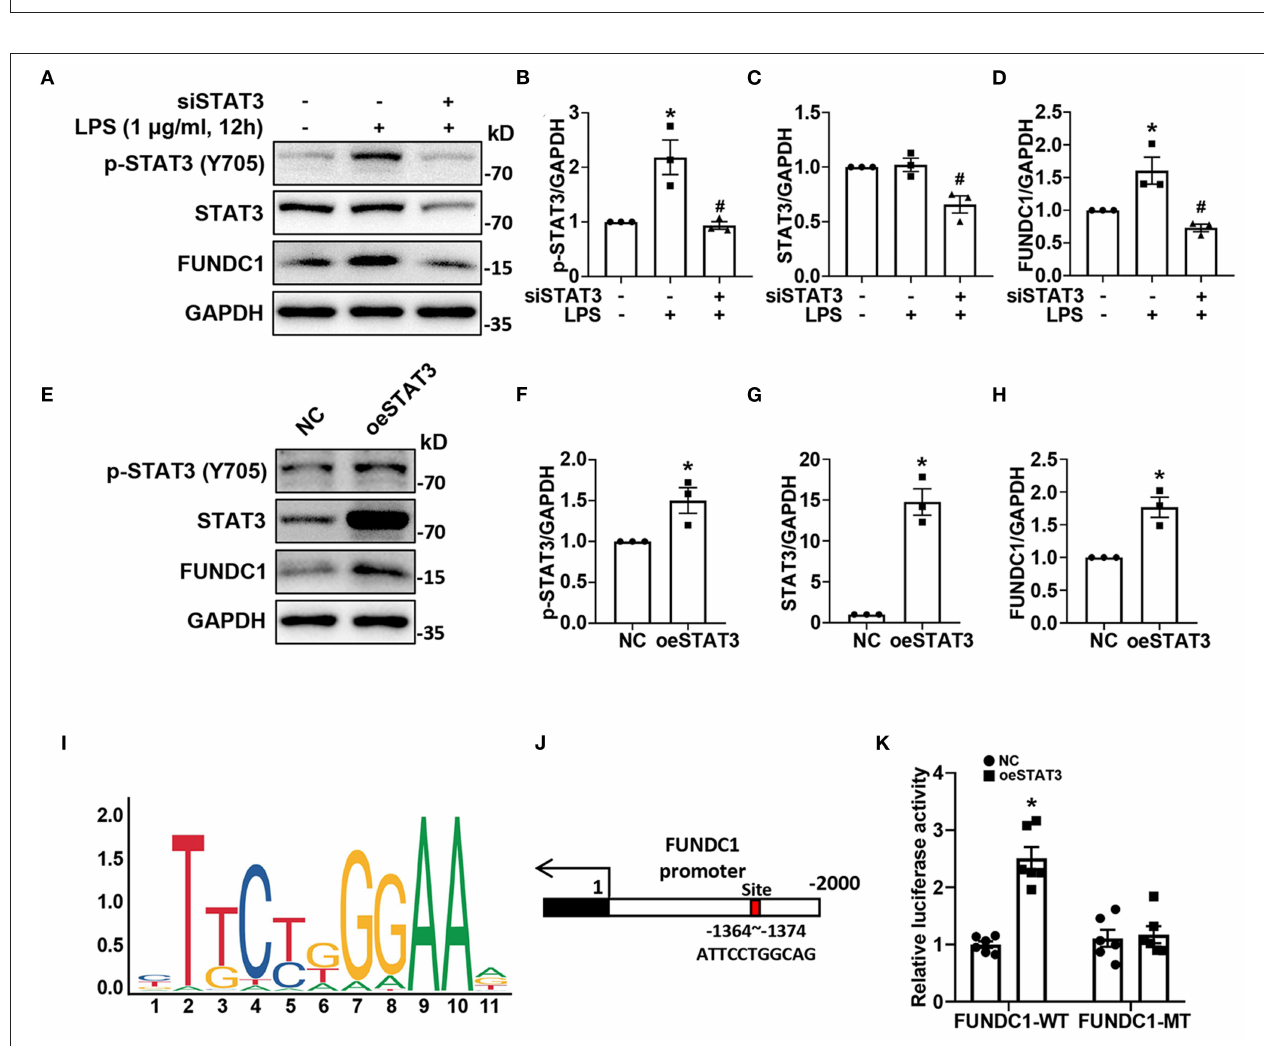
FIGURE 3 | H9c2 cells were pretreated with 5 µ M Bazedoxifene for 1h and then stimulated by LPS (1 µ g/ml) for another 12h. Western blot was used to determine the levels of p-STAT3 and STAT3. (G,H) Representative immunofluorescence images and quantification for p-STAT3. Scale bar: 100 µ m. (I) Quantification of IL-6 mRNA level. (J,K) The impact of various concentrations of sIL-6R on the activation of STAT3 induced by LPS. H9c2 cells were co-treated with LPS and sIL-6R (0, 2.5, 5, 10, 20ng/ml) for 12h. Representative western blot images and quantification of p-STAT3 and STAT3 were as indicated in the figure. n = 6 (A,D) , 3 (B,C,E,F, I) , and 4 (G,H,J,K) per group. Data represent means ± S.E.M. * p < 0.05 vs. control; # p < 0.05 vs. LPS treatment. Statistical analyses were performed using one-way ANOVA followed by Bonferroni’s post-hoc test. BAZ, Bazedoxifene.